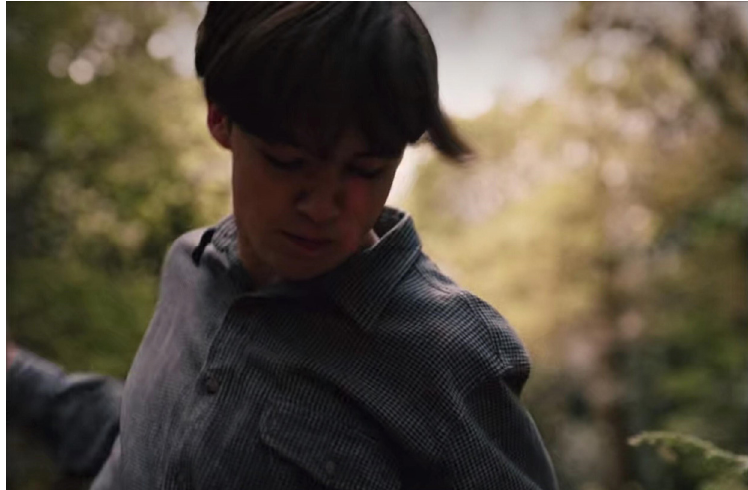
Figure 2. Close-up of James. Pilot (1 × 01). Source: Clerkenwell Films.